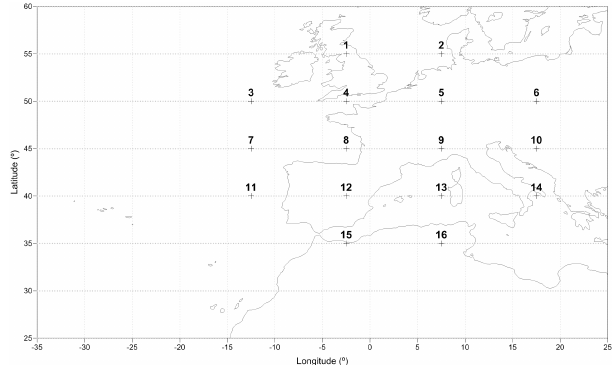
Figure 4. Locations of the 16 points used for the circulation weather type